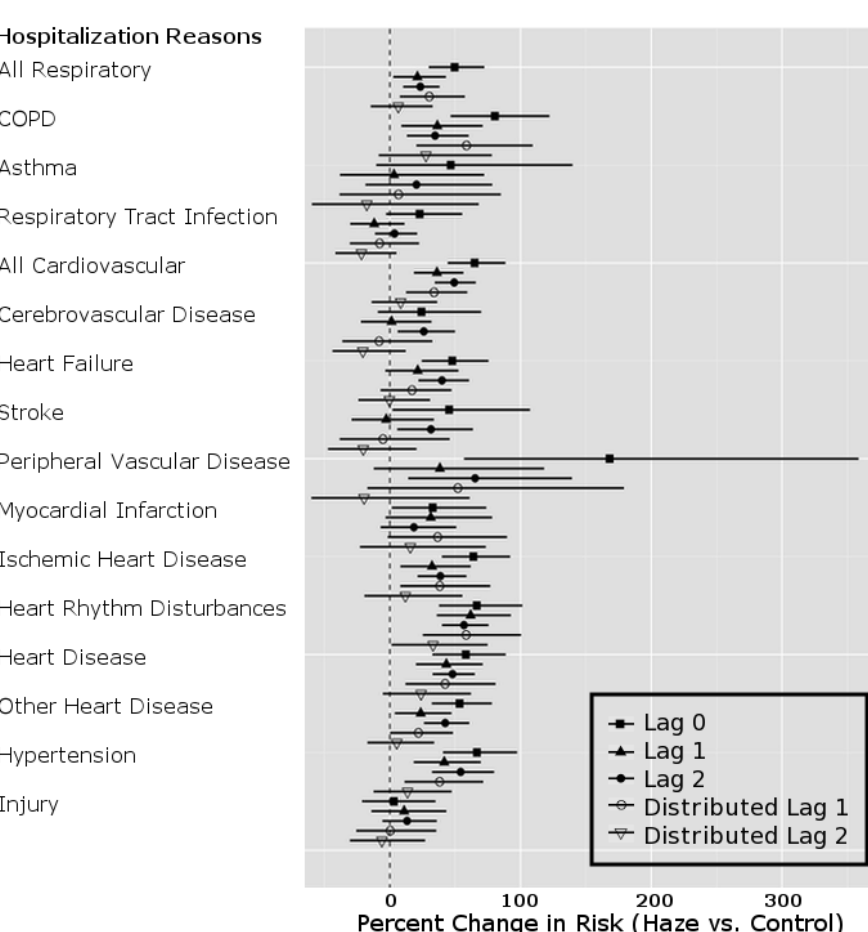
, temperature, 2.5